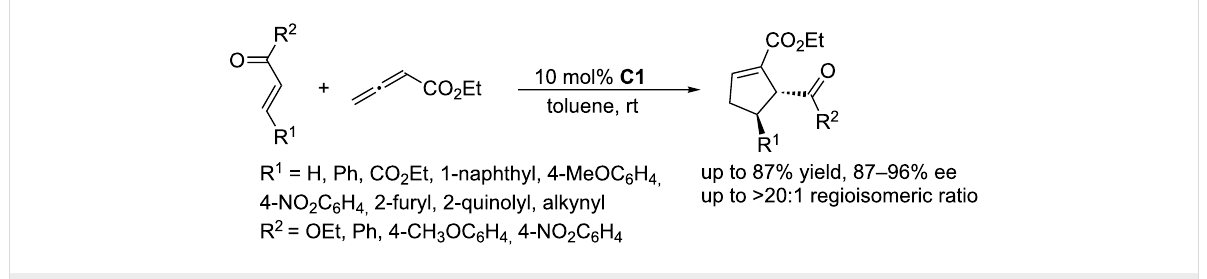
Scheme 9: Asymmetric [3 + 2] annulations of α , β -unsaturated esters and ketones with an allenoate, catalyzed by the ferrocene-modified phosphine C1 .